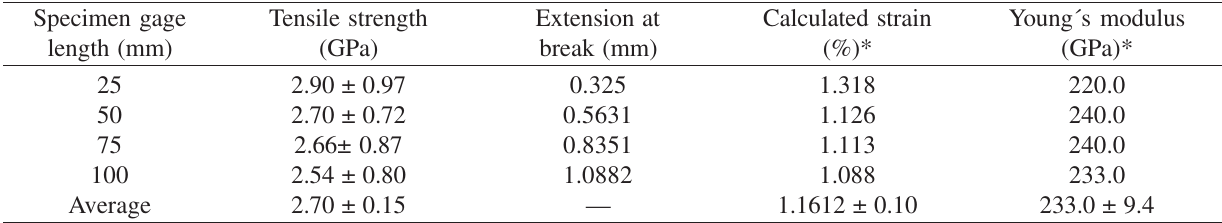
Table 1. Properties of the carbon fibre at various specimen gage length.